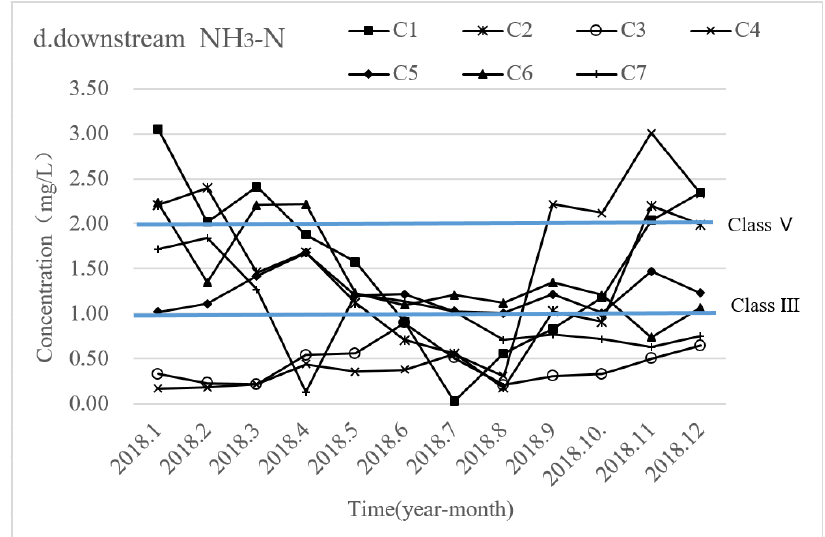
Figure 4. The changes in COD Mn and NH 3 -N concentrations under the current floodgate operation. ( a ) COD Mn concentration in the upstream; ( b ) COD Mn concentration in the downstream; ( c ) NH 3 -N concentration in the upstream; ( d ) NH 3 -N concentration in the downstream.